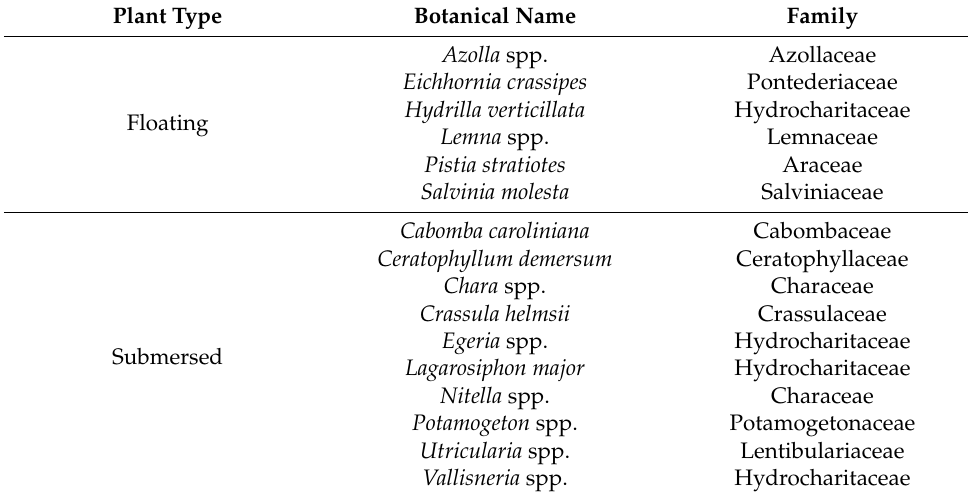
Figure 1. Three types of aquatic weeds. Table 1. Common aquatic weeds in the world [19,21–23].